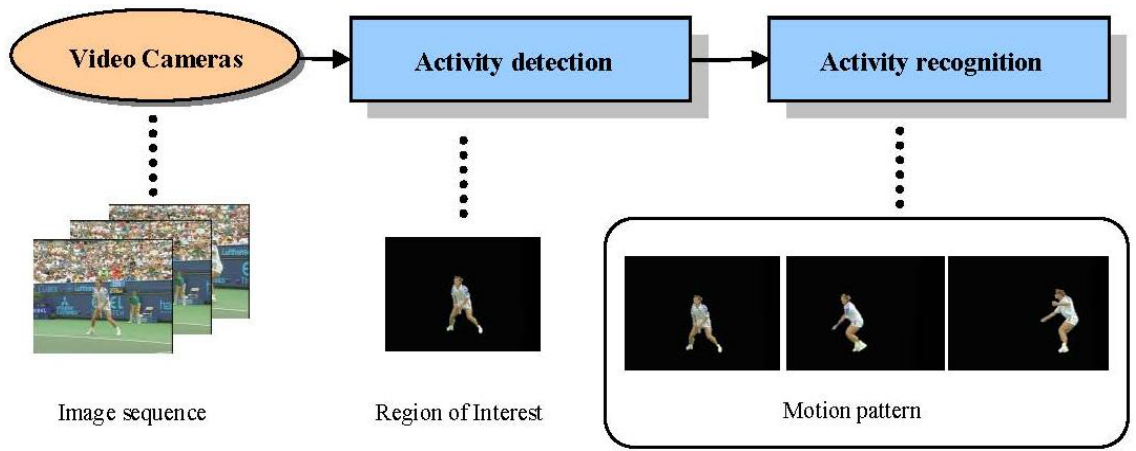
Figure 1. Flowchart of activity